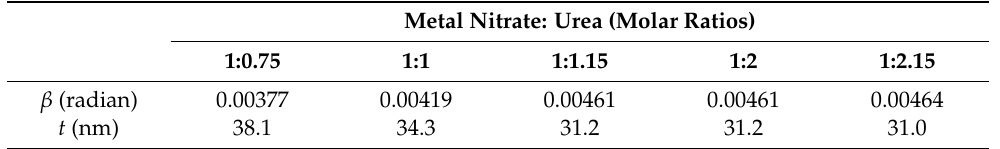
Figure 3. XRD spectra of τ-phase Ba 1.3 Ca 0.7 SiO 4 powder samples as a function of the molar ratio of metal nitrate:urea (after post-annealing at 750 °C for 2 h). Table 1. Crystallite size (t) of τ-phase Ba 1.3 Ca 0.7 SiO 4 silicate powders at θ = 15.42 °, i.e., (101) crystallographic plane. Here, β denotes a full width at half maximum (FWHM).